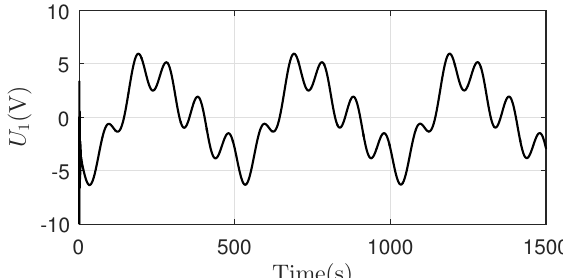
Figure 8. Control input U 1 in submerging motion with a variable velocity and constant pitch angle command.